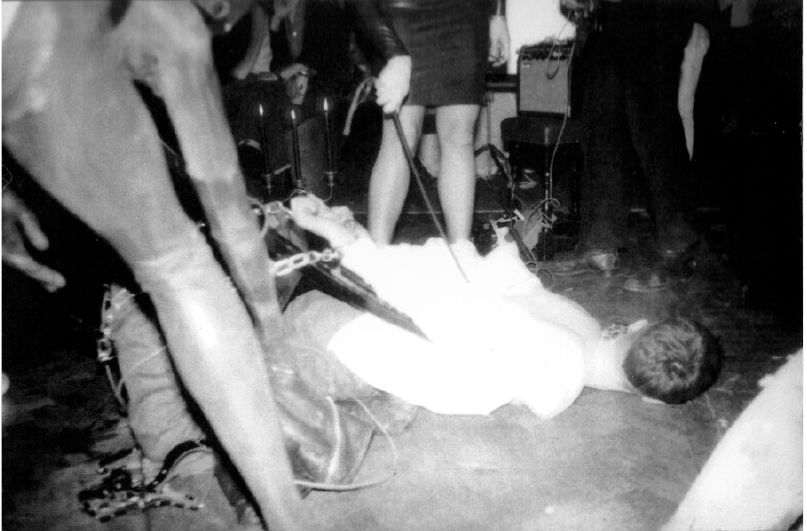
Figure 3. Fistfuck, performance, AIR Gallery, London, January